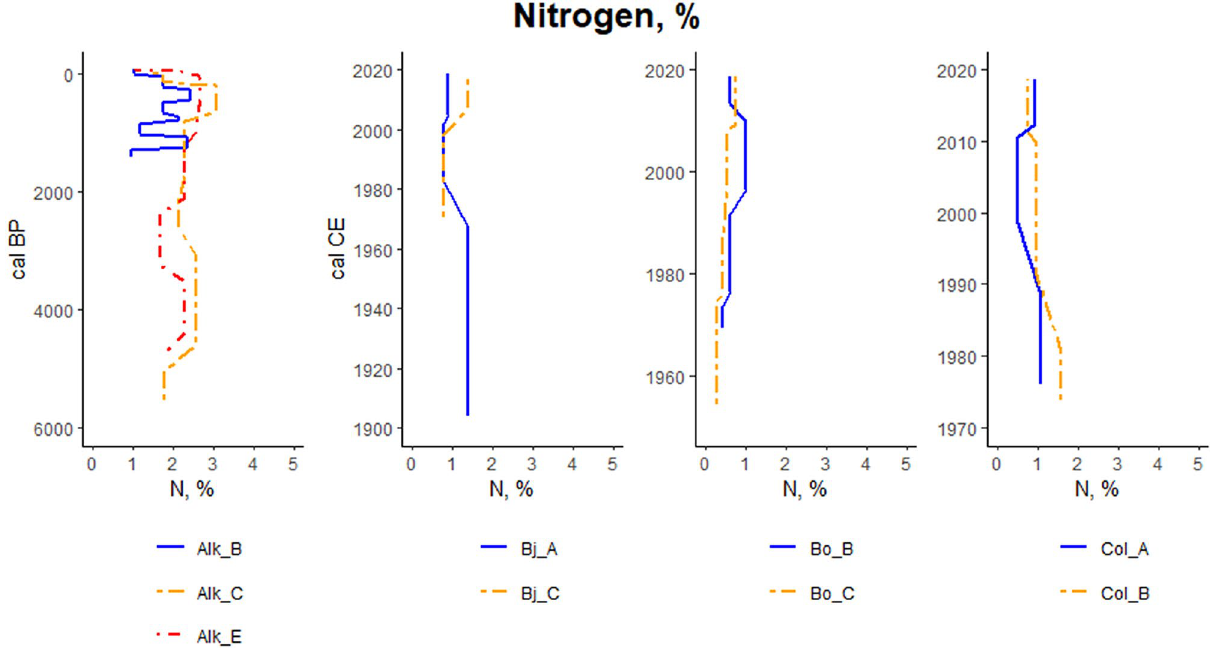
Figure 9. Nitrogen content (%) variation at different soil layers for focus section study points. Each panel represent different study site. For the study site Alkhornet (Alk), age is presented as calibrated Before Present (cal BP) while for Bjørndalen (Bj), Bolterdalen (Bo) and Colesdalen (Col) ages are presented as calibrated Common Era (cal, CE).